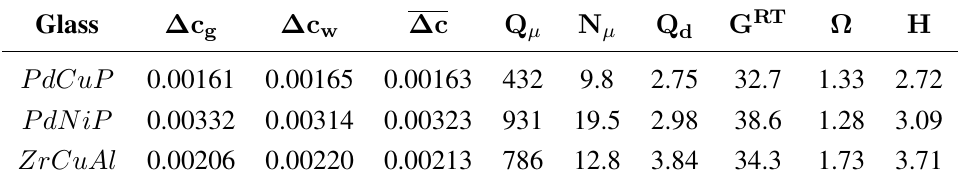
Table 1. Parameters of structural relaxation of Pd- and Zr-based glasses [72]: the ∫ = n ( E ) dE change of the defect concentration ∆ c determined from G-measurements g g 0 0 (where n is calculated using Equation (9)), the change of the defect concentration g ∫ ∆ c = n ( E ) dE determined from DSC measurements (where n is determined using w w 0 0 w + ∆ c ) = 2 , molar heat of structural Equation (17)), averaged concentration ∆ c = (∆ c g w = ∆ cN relaxation Q (J/mole), number of defects per mole N ( × 10 (cid:0) 20 mole (cid:0) 1 ), heat (cid:22) (cid:22) A = Q =N of structural relaxation per defect Q (eV), room-temperature shear modulus d (cid:22) (cid:22) G RT (GPa), volume per atom Ω = m (cid:22) ( × 10 (cid:0) 29 m 3 ) and interstitialcy formation enthalpy (cid:26)N A H = (cid:11)G Ω